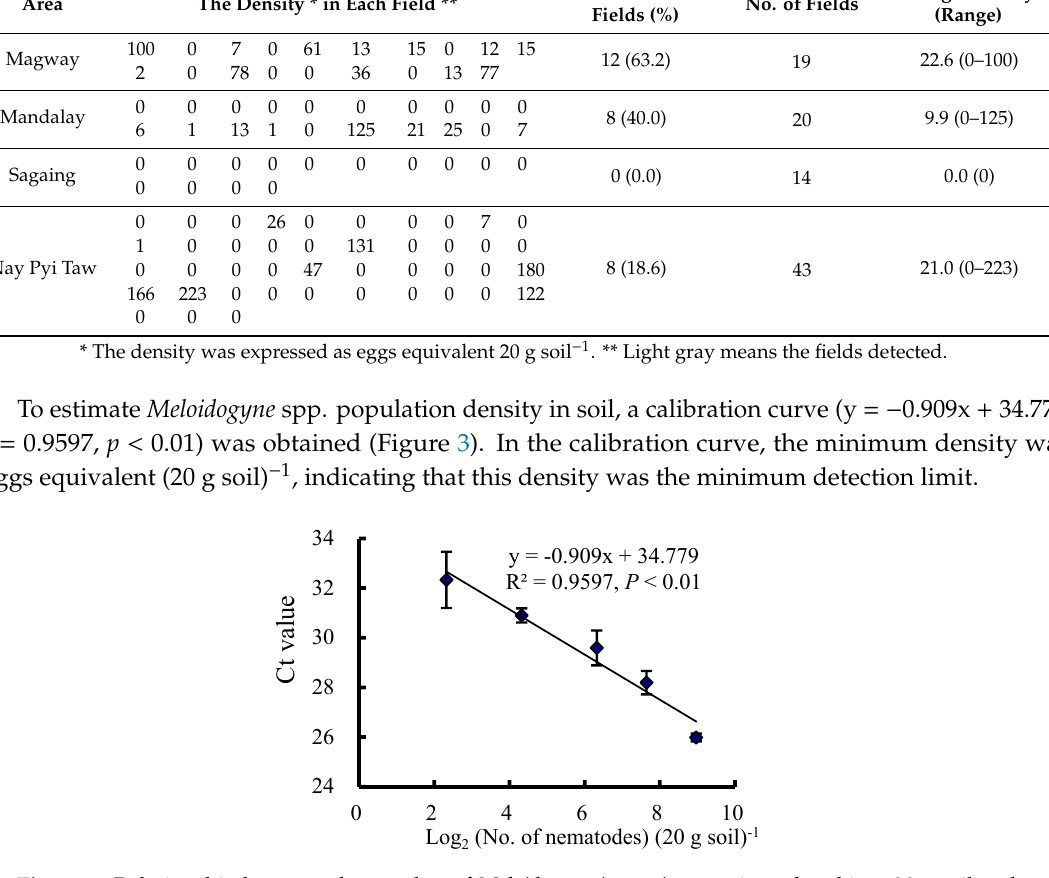
Table 2. The density of Heterodera cajani in soils of four sesame growing areas in Myanmar. Area The Density * in Each Field **